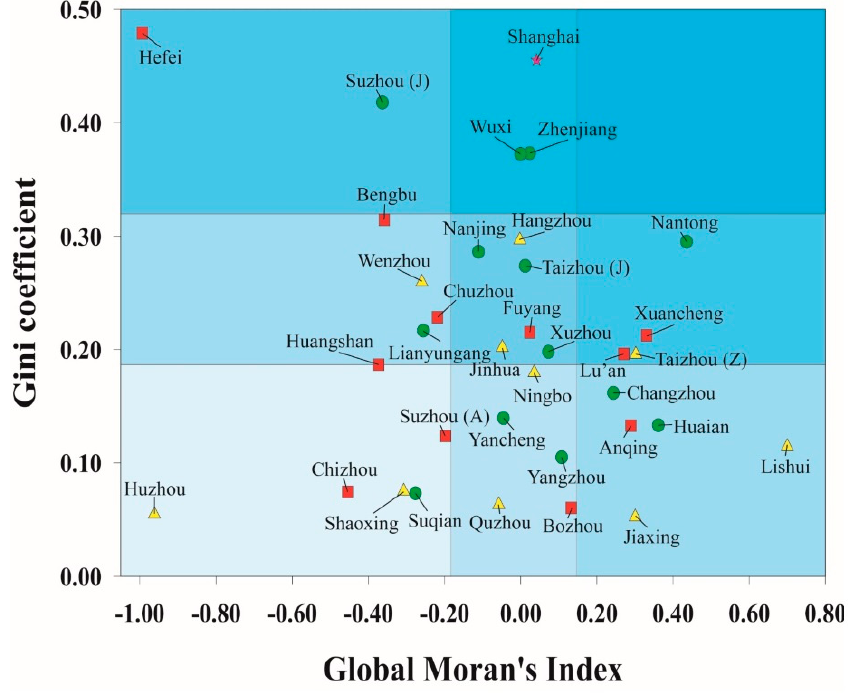
Figure 6. Reclassification of city types according to the spatial spread of inequality.